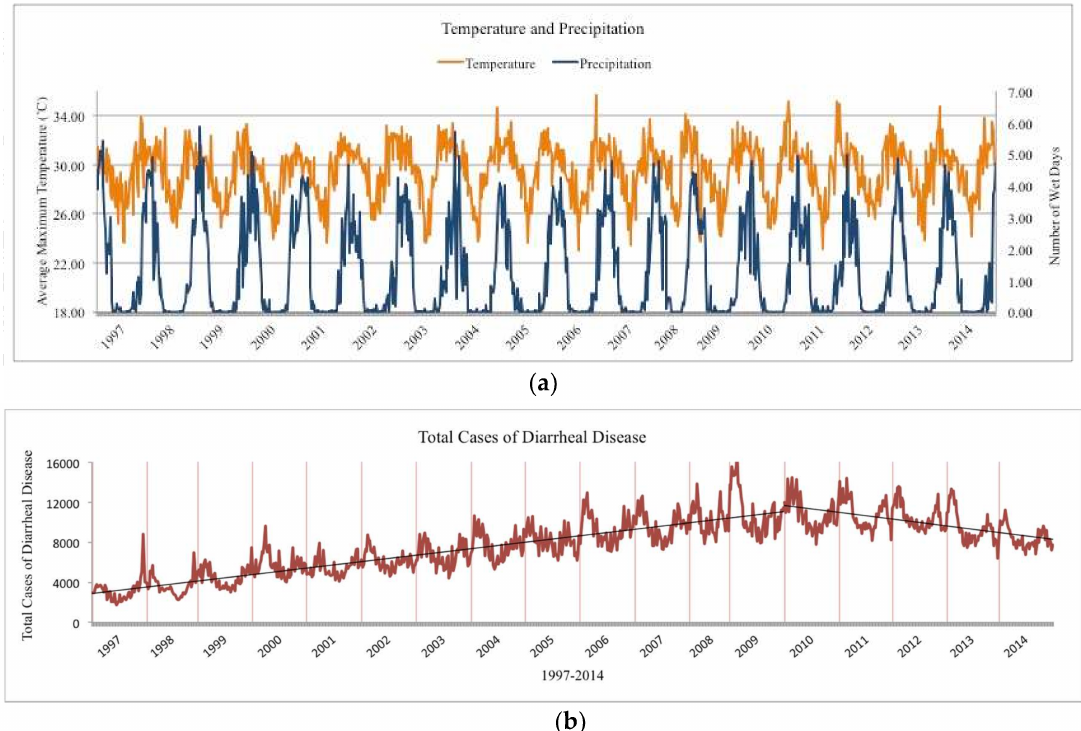
Figure 1. Temporal variation in climatic variables and diarrheal disease in Mozambique, 1997–2014, among all 141 administrative districts. ( a ) Temperature (orange, x -axis) and precipitation (blue, y -axis) defined as the number of wet days (precipitation < 1 mm per week) by week of follow-up; ( b ) Total number of cases in Mozambique by week of follow-up.